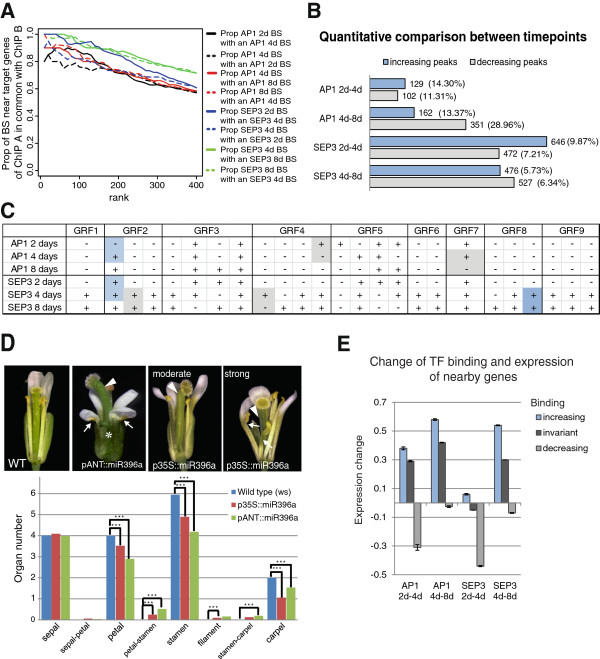
Developmental dynamics of MADS-domain TF-bound genomic regions. (A) Proportion of overlapping AP1 or SEP3 BSs between time points depending on their rank (1 = highest rank). Only peaks near genes (3 kb upstream to 1 kb downstream of the gene) were considered. (B) Changes in AP1 and SEP3 BSs between consecutive time points. ‘Increasing peaks’ and ‘decreasing peaks’ are genomic regions with a peak score at least two-fold higher or two-fold lower, respectively, when compared with the previous time point. Only significant peaks (FDR <0.001) near genes in at least one time point are considered. (C) Summary of AP1 and SEP3 BSs at GRF loci. Each locus has a number of columns depending on the number of different AP1 or SEP3 BSs at any time point. For each column, ‘–’ indicates that the region was not bound and ‘+’ that it was bound (FDR <0.001); two consecutive time points are colored in gray when the ChIP-seq score of the earlier time point is at least two-fold higher than at the later time point and in blue when it is two-fold lower. (D) Floral phenotypes of plants expressing miRNA396 from the 35S or pANT promoter. One sepal and petal were removed for visualization. Arrow indicates petal-stamen organs, asterisk indicates conversion of floral organs into filament, arrowhead indicates ovary composed of a single valve in mutant flowers. In the column chart, data are represented as means, 100 flowers of each genotype were assessed. *** indicates significant difference at P value <0.001 by unpaired Student’s t test. (E) Mean change of log10 fold expression of genes in vicinity (up to 1 kb upstream of start or inside the gene) of different classes of AP1- and SEP3-bound genomic regions. Only differentially expressed genes were used (Additional file 7: Table S4). Bars correspond to standard error of mean.